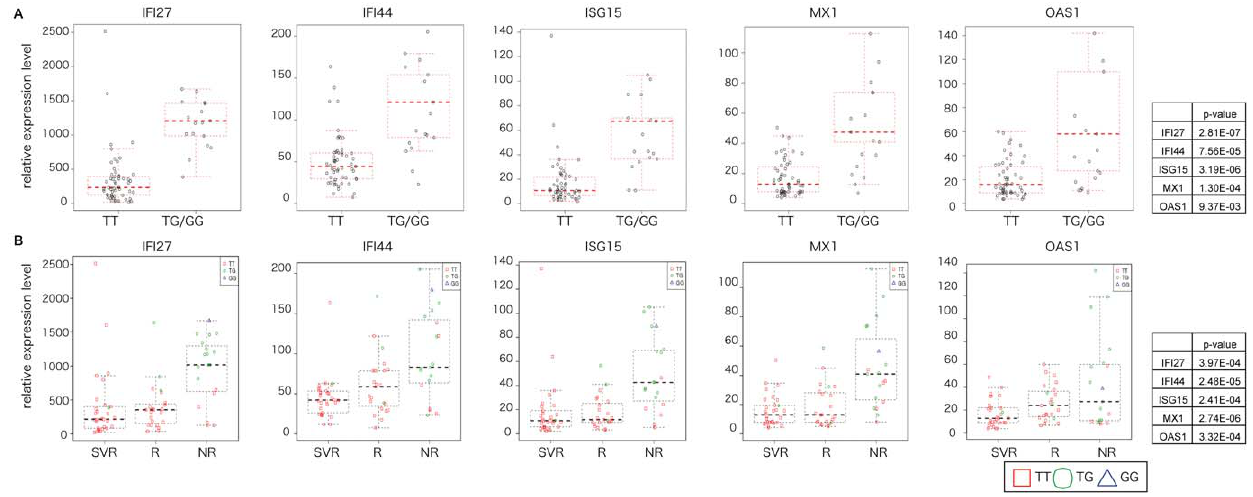
Figure 2. The relationship among the expression of IFN-related genes, IL28B polymorphism and clinical outcome. (A) The relationship between expression of ISG and five related genes (MX1, OAS1, ISG15, IFI27, and IFI44) in the liver of CH patients and IL28B with the major (TT) or minor (TG or GG) genotype (rs8099917) is shown. The p-value of the relationship between gene expression level and IL28B genotype is also depicted. (B) The relationship among the expression level of the above five genes, clinical outcome, and IL28 genotype in individual cases. Red square, green circle, and blue rectangle represent TT, TG, and GG in IL28B genotype, respectively. The p value was calculated from a linear regression employing outcome as an explanatory variable (in which SVR, R and NR are encoded to 0, 1 and 2 respectively) and expression level as the response variable. We tested the null hypothesis that the coefficient of the outcome is 0. Summary table of the p-value is also shown. NS shows no significant difference.